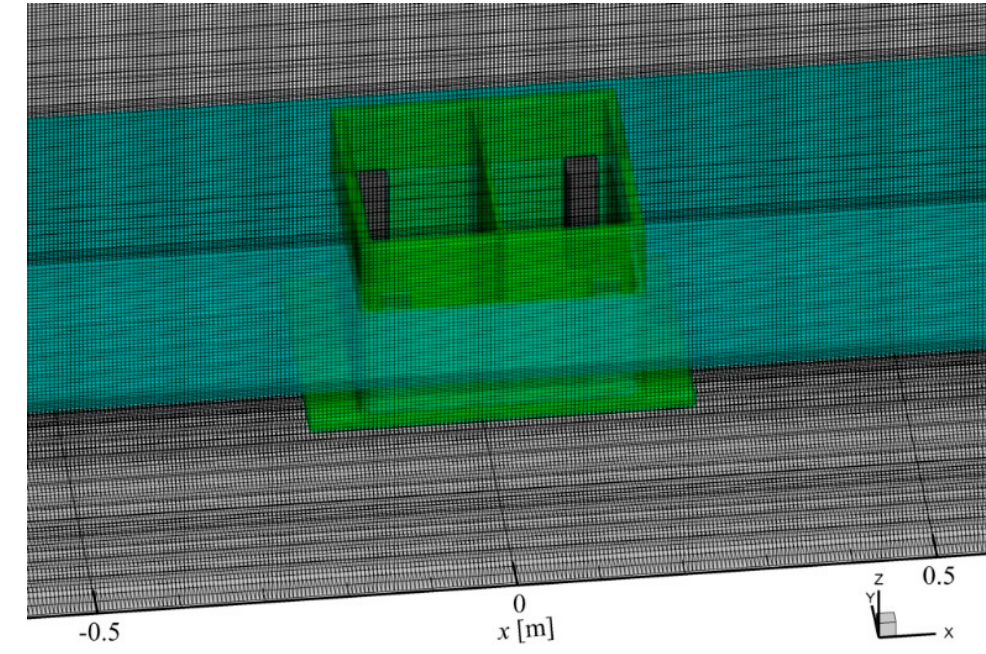
Figure 13. Numerical cells around the initial position of the caisson.